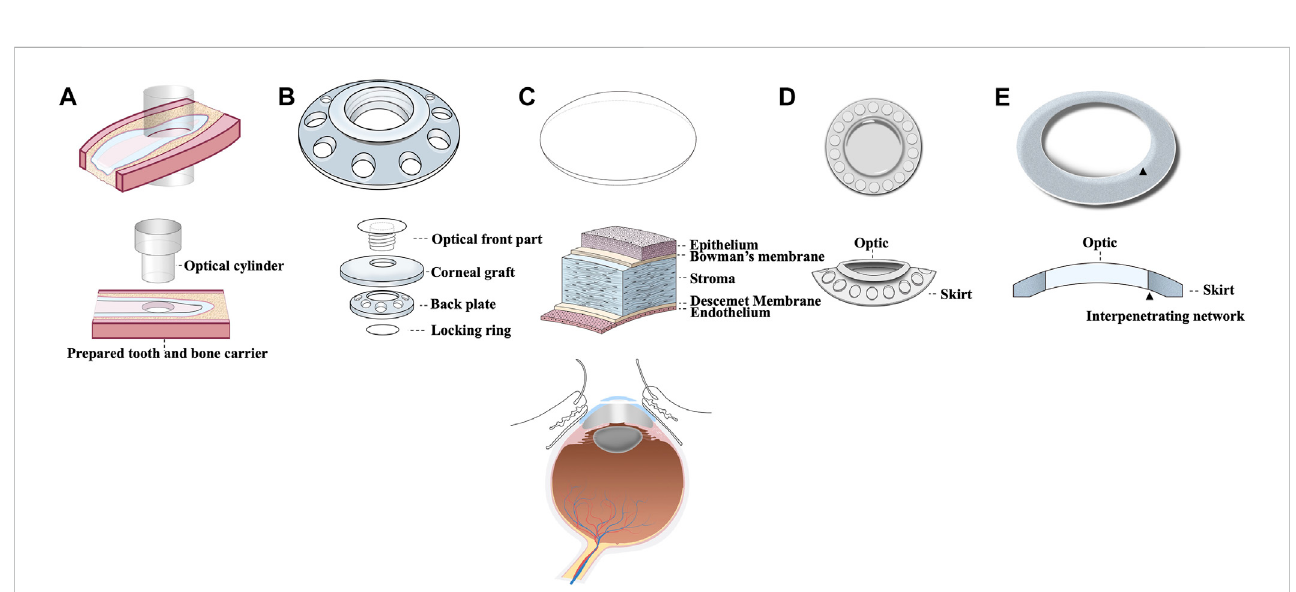
FIGURE 2 Schematic images of 5 commonly used corneal transplants including (A) OOKP, (B) Boston KPro, (C) Donor graft, (D) Keraclear, and (E) AlphaCor.